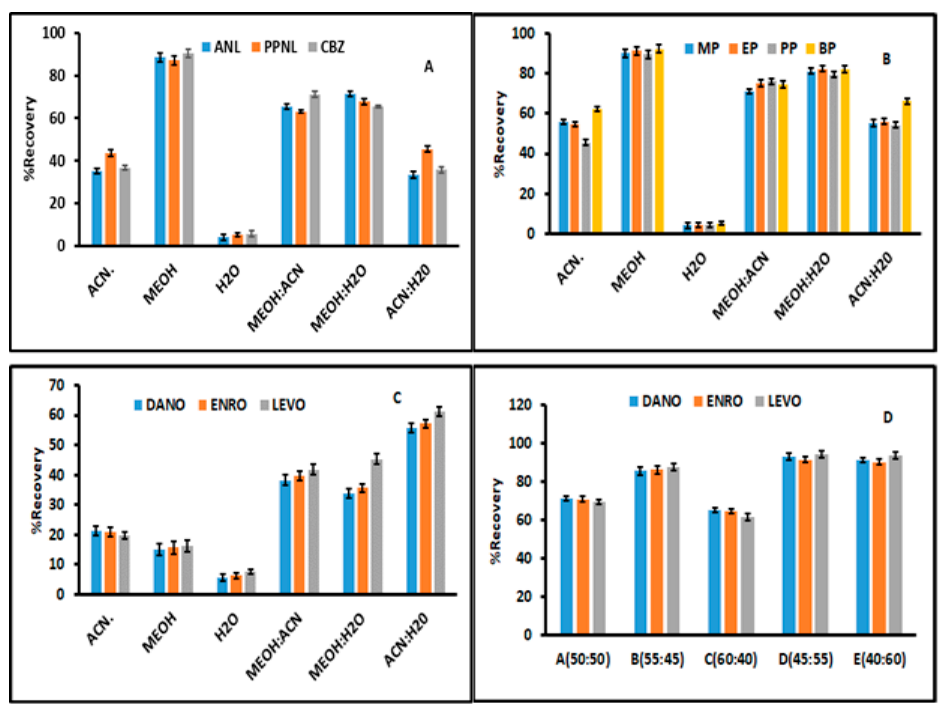
Figure 1. Recoveries of different elution volumes using different solvents for residual analytes. ( A ) Anticonvulsants and β -blockers (atenolol (ANL), propranolol hydrochloride (PPNL) and carbamazepine (CBZ)), ( B ) parabens (methylparaben (MP), ethylparaben (EP), propylparaben (PP) and butylparaben (BP)), ( C , D ) fluoroquinolones (danofloxacin (DANO), enrofloxacin (ENRO), levofloxacin (LEVO)).